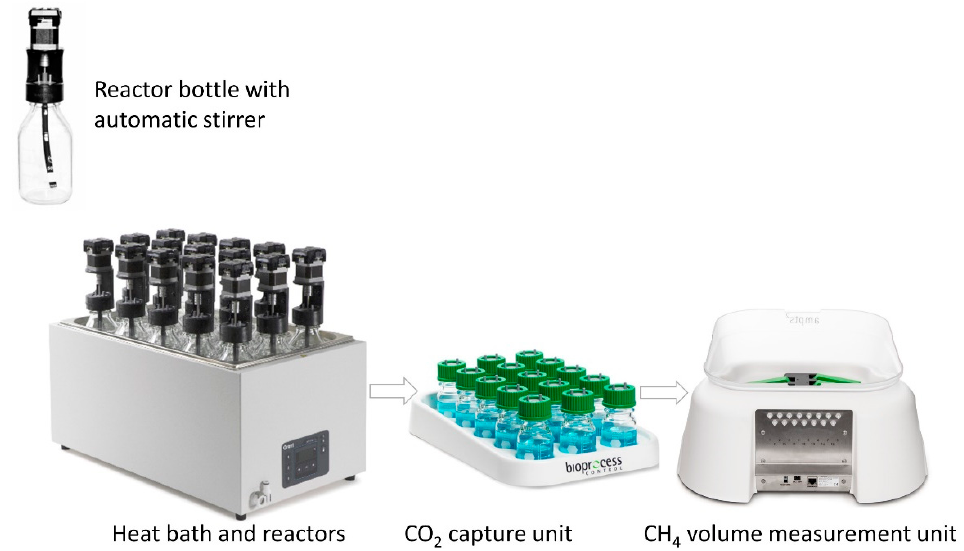
Figure 3. Automatic methane potential test system (AMPTS) II batch reactor experimental setup (pictures from Bioprocess control’s homepage).